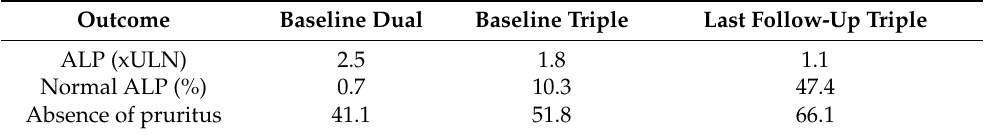
Table 4. Outcomes of triple therapy (UDCA + fibrates + OCA)